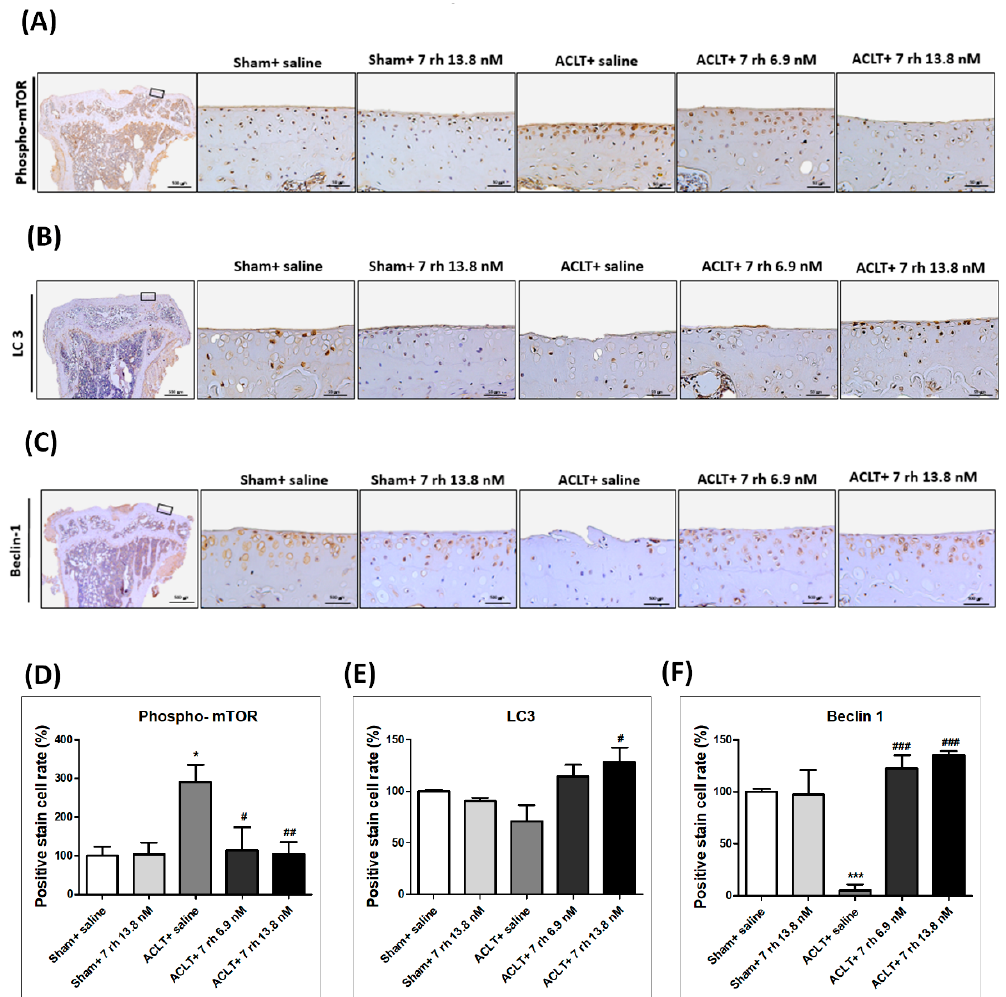
Figure 6. E ff ect of 7 rh mediated enhanced autophagy-related proteins in articular cartilage. ( A ) The representative micrographs of immunolocalized phosphorylation of mechanistic target of rapamycin (phospho-mTOR) in articular cartilage of the sham control groups (sham + saline and sham + 7 rh 13.8 nM), ACLT, and two 7 rh treated groups. ( B ) The representative micrographs of immunolocalized light chain 3 (LC3). ( C ) The representative micrographs of immunolocalized beclin-1. ( D ) Quantitative analysis of the immunohistochemical (IHC) staining of phospho-mTOR. ( E ) Quantitative analysis of the IHC staining of LC3. ( F ) Quantitative analysis of the IHC immunohistochemical staining of beclin-1. versus the sham control groups; *** p < 0.001 versus the sham control groups; # p < 0.05 versus the ACLT group; ## p < 0.005 versus the ACLT-OA group; ### p < 0.001 versus the ACLT